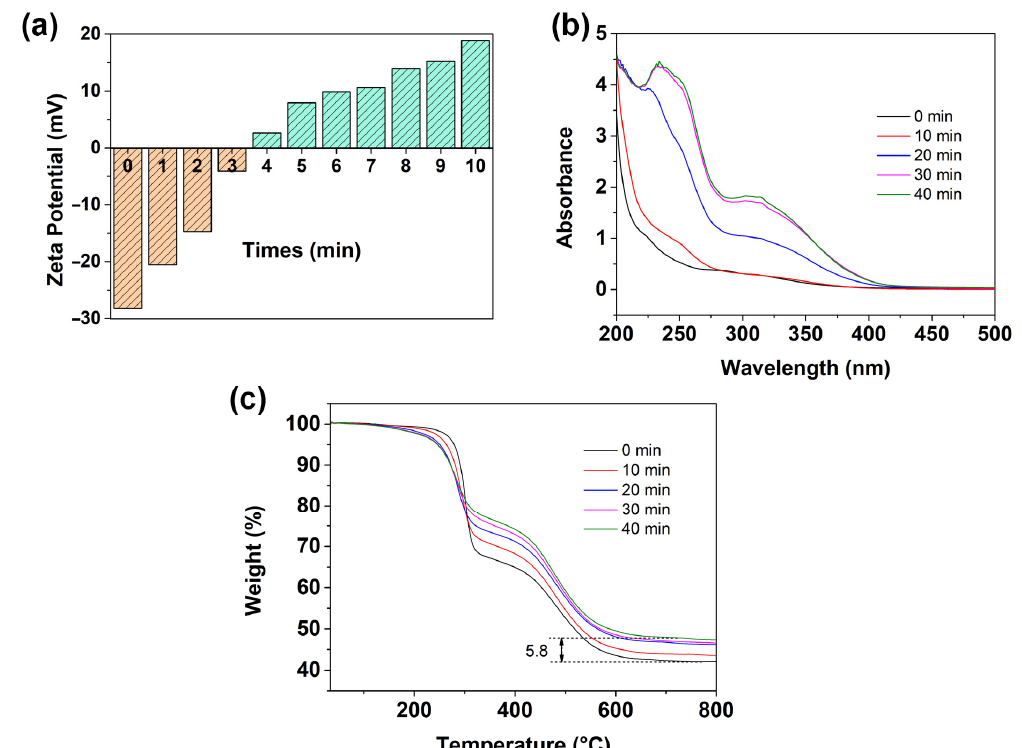
Figure 4. Zeta potential ( a ), UV–vis absorption spectra ( b ), and TGA curves ( c ) of BPS upon light irradiation for various times.